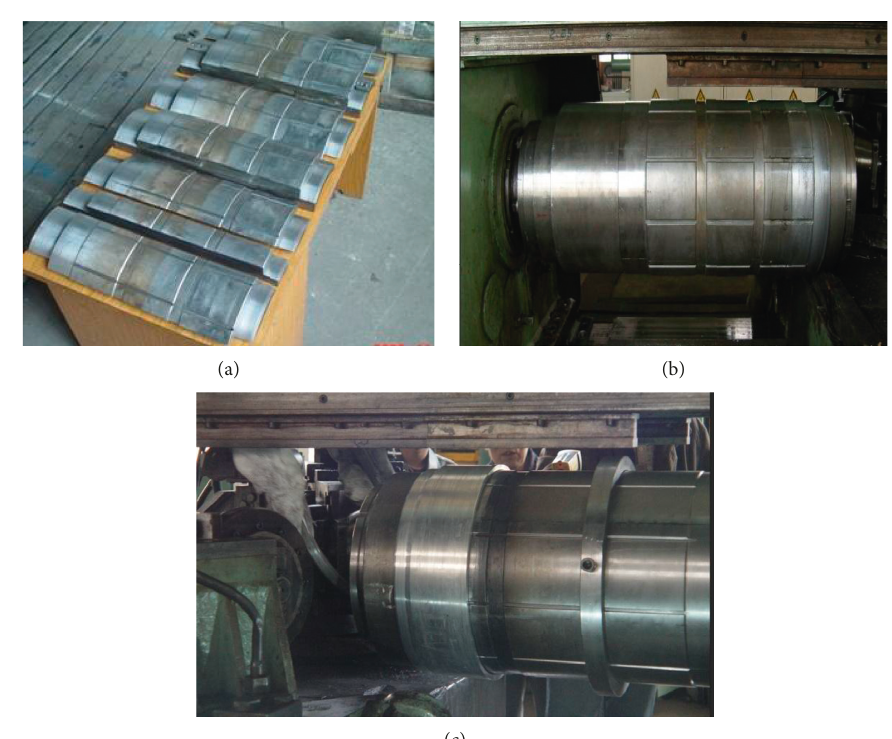
Figure 17: (a) Split state, (b) assembled state, and (c) installation state of the